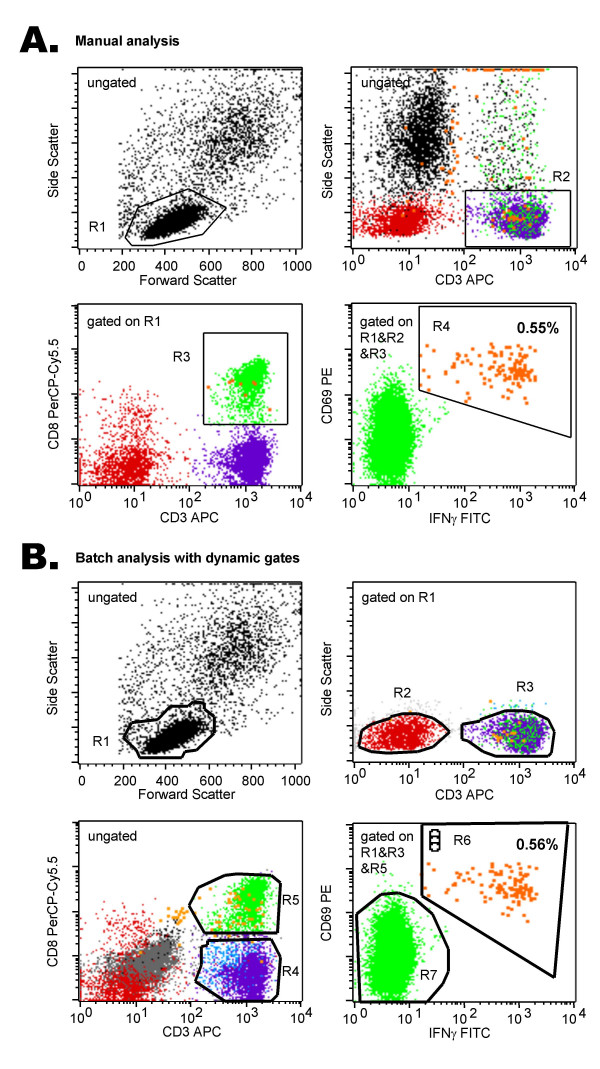
Manual versus automated gating templates. (A) Representative manual analysis of a CEF-stimulated sample from Experiment 4. Sequential gates on small lymphocytes, CD3+ cells, and CD3+CD8+. cells are applied and the percent CD69+IFNg+ cells are determined from a plot gated on all of these regions. (B) Dynamic gating template for the same data file as above. Sequential dynamic gates ("Snap-To" gates) are applied as above, except that negative populations are also gated so as to provide a boundary for the movement of the positive region. The percent CD69+IFNg+ cells obtained is very similar to that obtained by manual gating in this example, since manual gating was performed so as to include CD3dim and CD8dim cells.